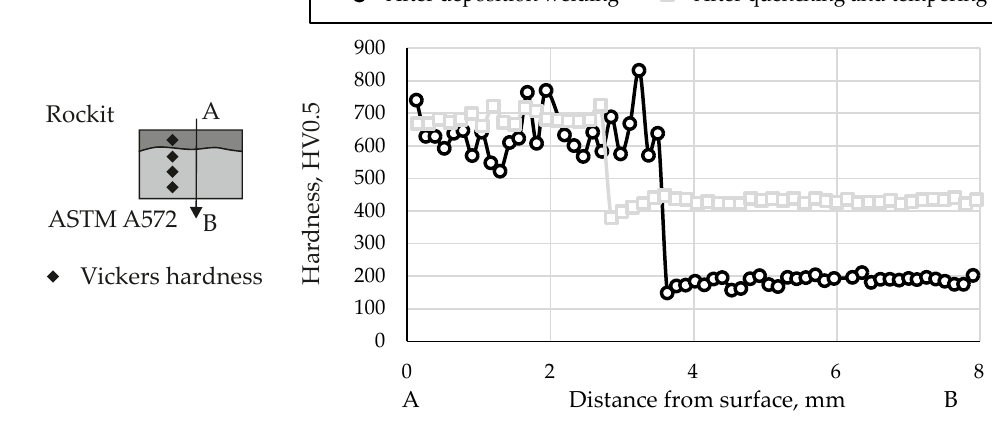
Figure 5. Hardness profiles of the hybrid Rockit ® bearing washers.